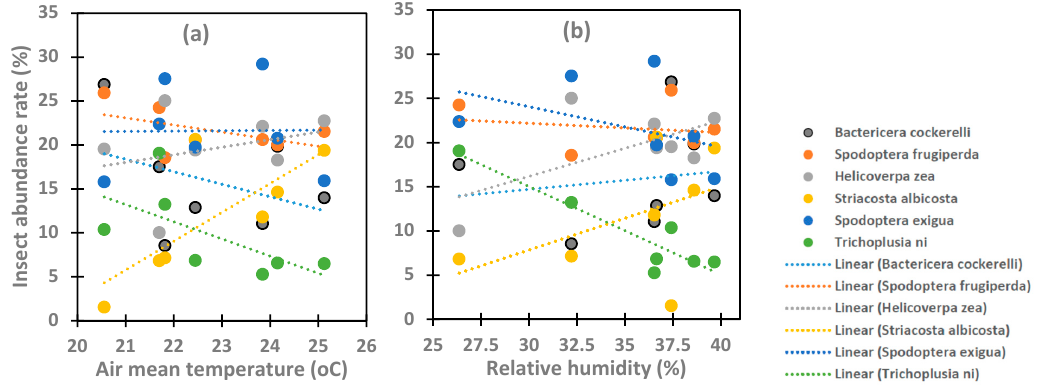
Figure 9. Correlation between insect abundance and ( a ) average air temperature and ( b ) air relative humidity for the study area.